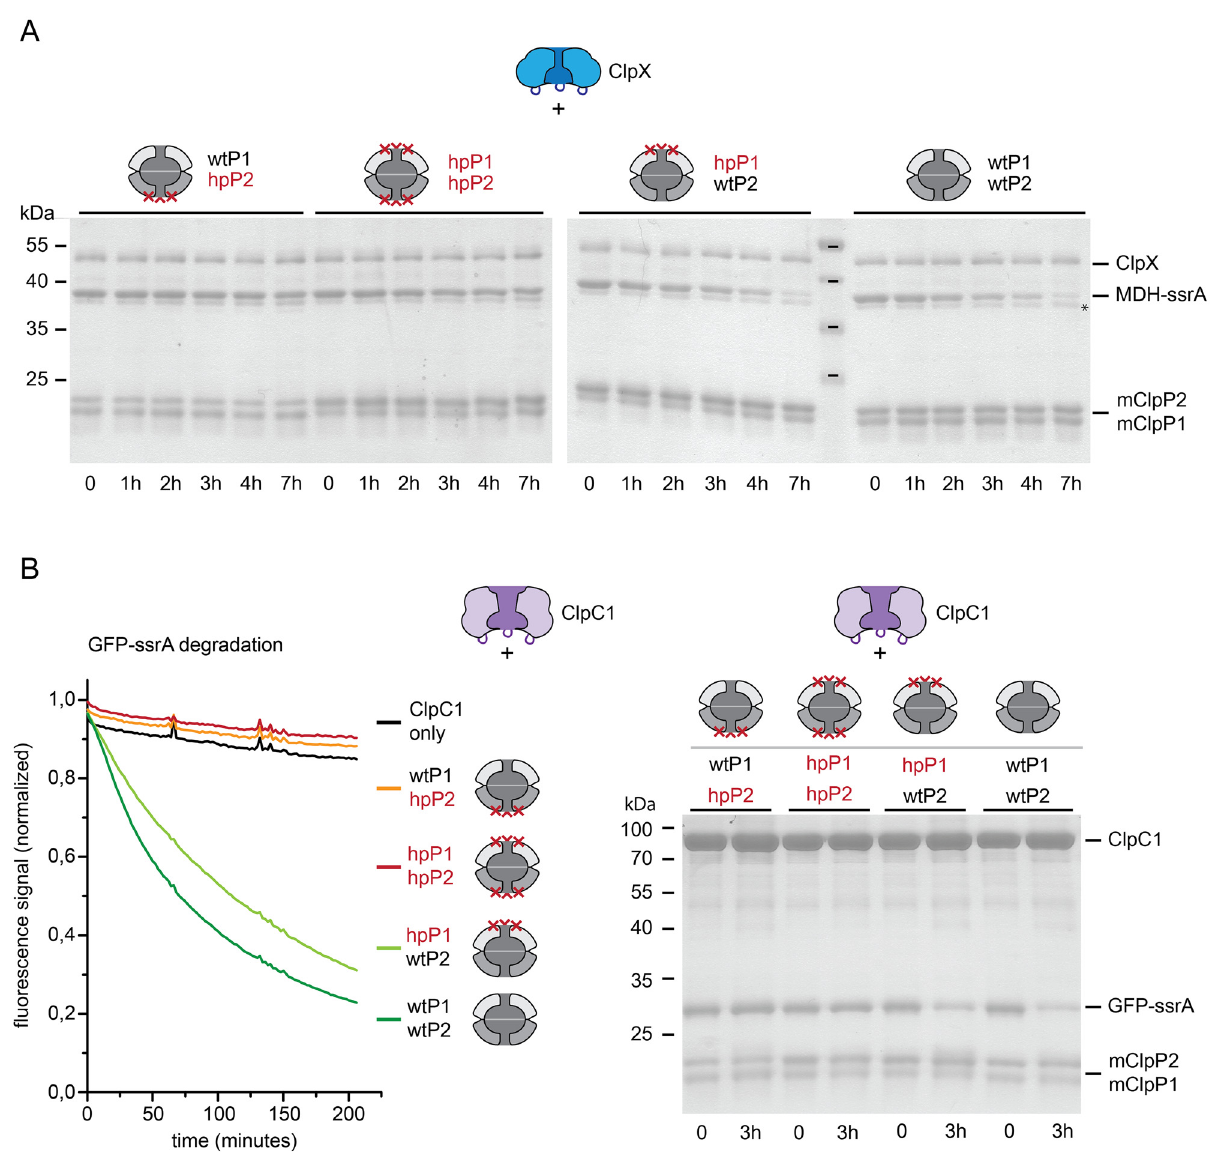
Fig 4. Chaperone-mediated degradation of ssrA-tagged substrates by ClpP1P2 requires the hydrophobic patch on ClpP2. ClpX and ClpC1-dependent degradation of model substrates was assayed with a set of mature ClpP1P2 particles, created from mixed wild-type (wtP1, wtP2) and hydrophobic patch variants (hpP1, hpP2) of ClpP1 and ClpP2. A. Degradation of MDH-ssrA (2 μ M) mediated by ClpX (1 μ M hexamer) and wt, hp or mixed mature ClpP1P2 particles (0.5 μ M double-ring particle), was followed by the disappearance of the MDH-ssrA band in SDS-PAGE. The band just below MDH- ssrA that is not degraded ( * ) was confirmed by MS/MS to be composed of MDH, most probably lacking the ssrA tag. B. Degradation of GFP-ssrA (2 μ M) mediated by ClpC1 (1 μ M hexamer) and by wt, hp and mixed mature ClpP1P2 particles (0.5 μ M double-ring particle) was monitored by the loss of the intrinsic GFP fluorescence signal. The signal was globally normalized. Additionally, time points were taken at the beginning and the end of the reaction and degradation of GFP-ssrA was confirmed by